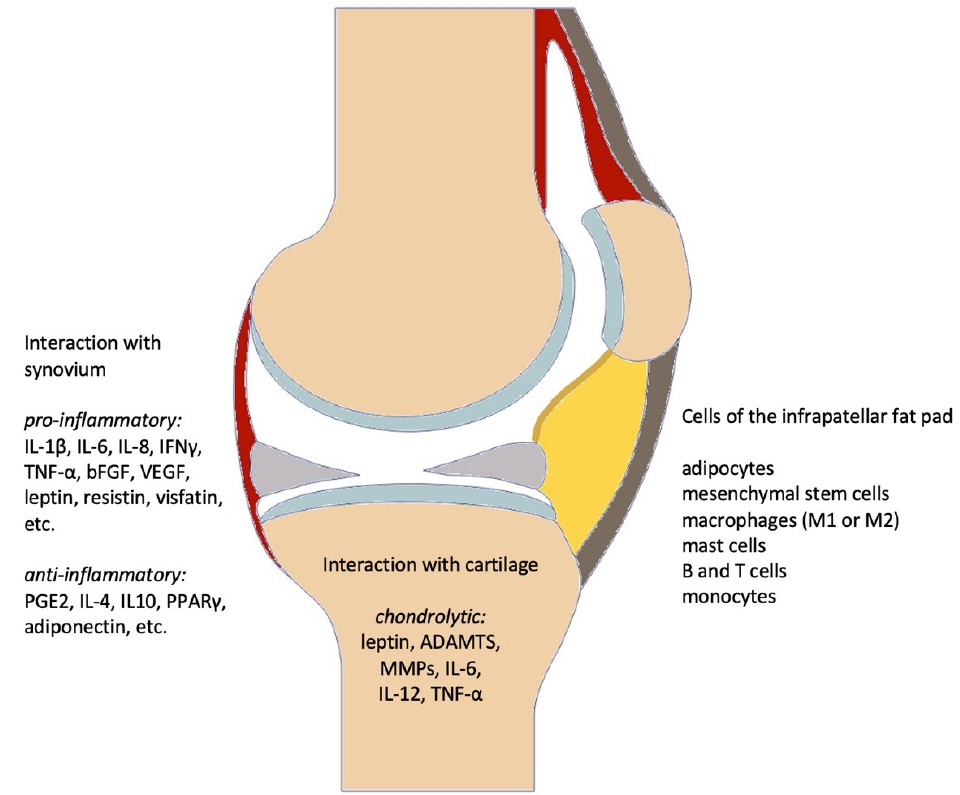
Figure 1. Mediators released by different cell types of the IFP and their molecular interactions with neighboring articular cartilage and synovium relevant in knee OA. brown: tibia, femur and patella, yellow: IFP, orange: synovial lining of the dorsal part of the IFP, red: joint capsule, grey: menisci, light blue: articular cartilage.